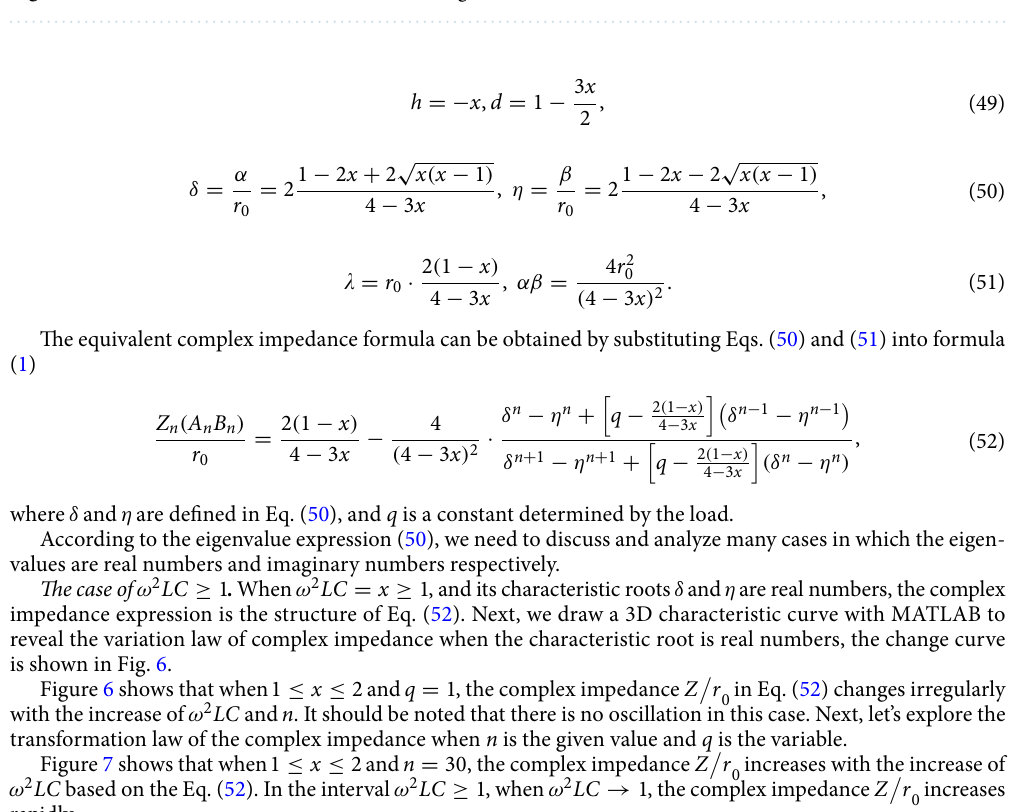
Figure 5. LC circuit sub network model with bridge circuit